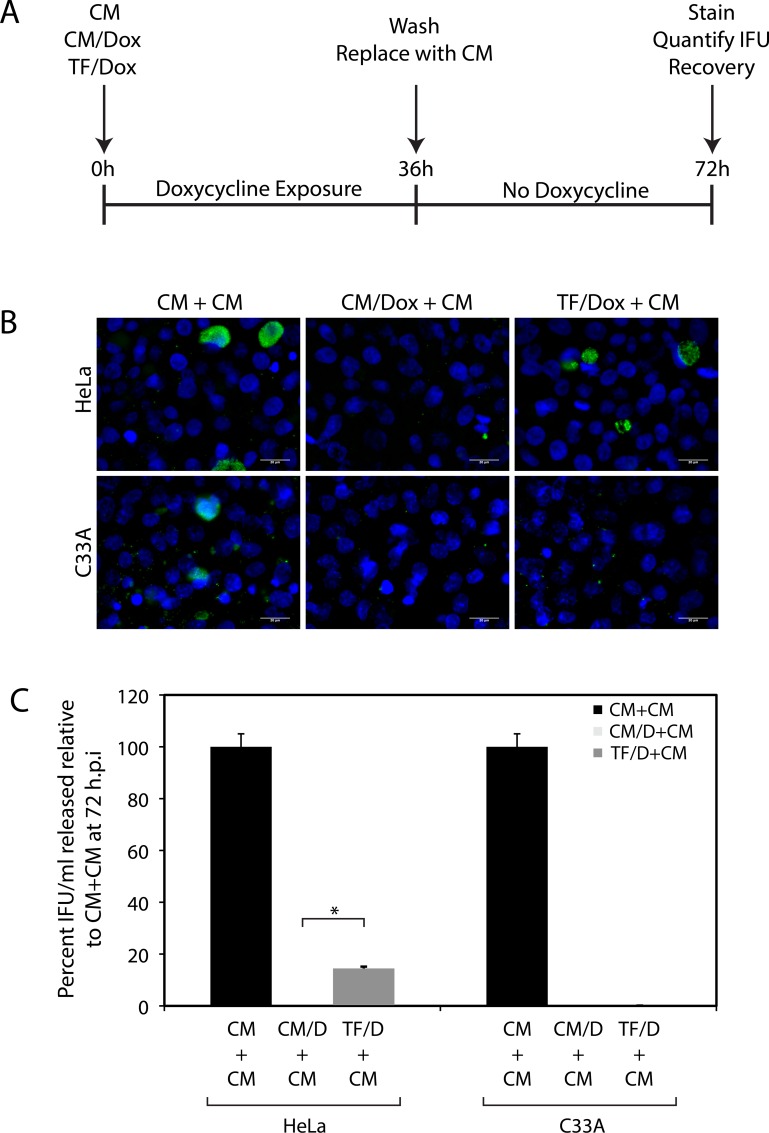
The efficacy of doxycycline treatment against C. trachomatis during tryptophan starvation is cell-line dependent.A) Schematic depiction of the experimental protocol. HeLa or C33A cells were infected with C. trachomatis. Post-infection, cells were maintained in complete media (CM), complete media with 1 μg/mL doxycycline (CM/Dox), or tryptophan-free media with 1 μg/mL doxycycline (TF/Dox). Infected cells were exposed to doxycycline for 36 hours, following which the media was replaced with complete media. After an additional 36 hours of growth in complete media, infected cells were evaluated for inclusion formation and IFU recovery. B) Immunofluorescence for chlamydial LPS to detect inclusions in infected HeLa and C33A cells under the three conditions described in “A”, i.e. CM + CM, CM/Dox + CM, and TF/Dox + CM. Cells were counterstained with Hoechst dye, and a scale bar of 20 μm is indicated. C) IFU/mL recovered under the three conditions indicated in “A” as a percent of the IFU/mL recovered under the CM + CM condition. IFU recovery was quantified by infection of HeLa cells. The bars represent the mean and standard deviation from three independent experiments. Significantly higher IFUs were recovered when infected HeLa cells were initially grown in the TF/Dox condition relative to the CM/Dox condition (* indicates p < 0.05 by the Wilcoxon rank sum test).